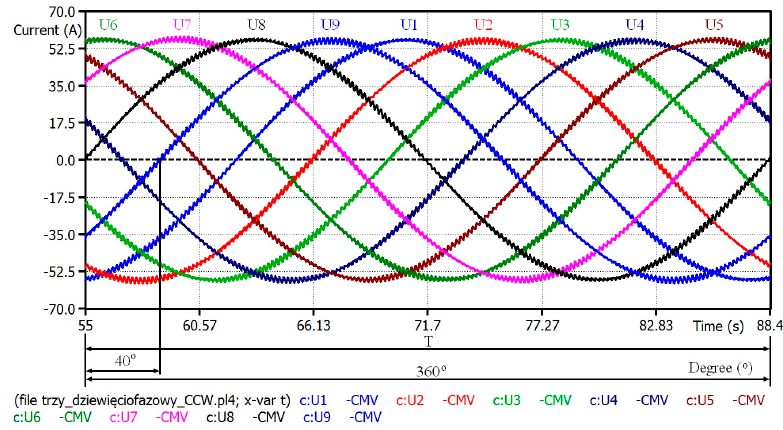
Figure 8. Waveforms of the output currents of phases from 1 to 9 for the CCW method and the CW method.